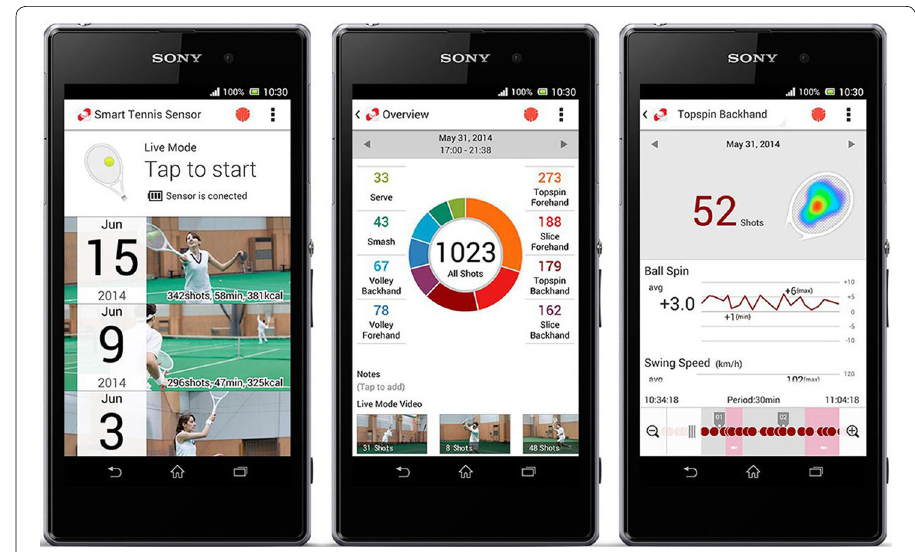
Fig. 10 An example of tennis data dashboards—Sony’s Smart Tennis Sensor. See also: http://www.sony.